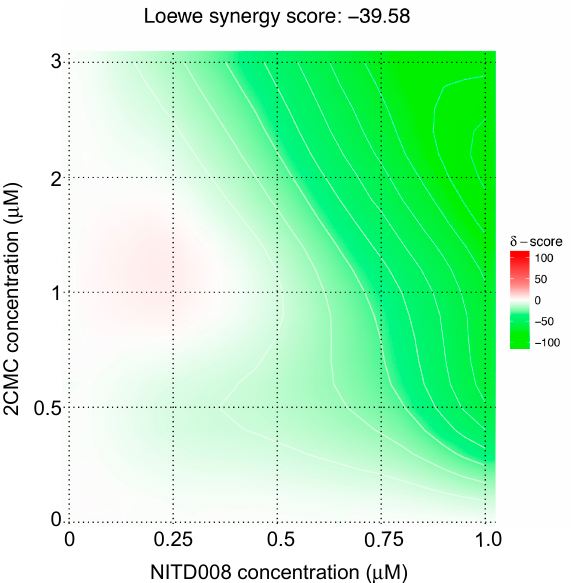
Figure 2. The interaction between the NITD008 and 2CMC is strongly antagonistic. The combinational e ff ects of 2CMC (0–3 µ M) and NITD008 (0–1 µ M) against MNV infection were tested over a range of concentrations using a plaque reduction assay. The percentage of inhibition observed across all drug combinations were tabled into a dose-response matrix and analyzed for synergy and antagonism using the Lowe-Additivity model on SynergyFinder. The synergy scores obtained for each drug combination across the entire matrix are presented as a heatmap. Synergistic (positive δ -score) and antagonistic (negative δ -score) interactions are represented in red and green respectively, and no observable e ff ect ( δ = 0) is represented as white.